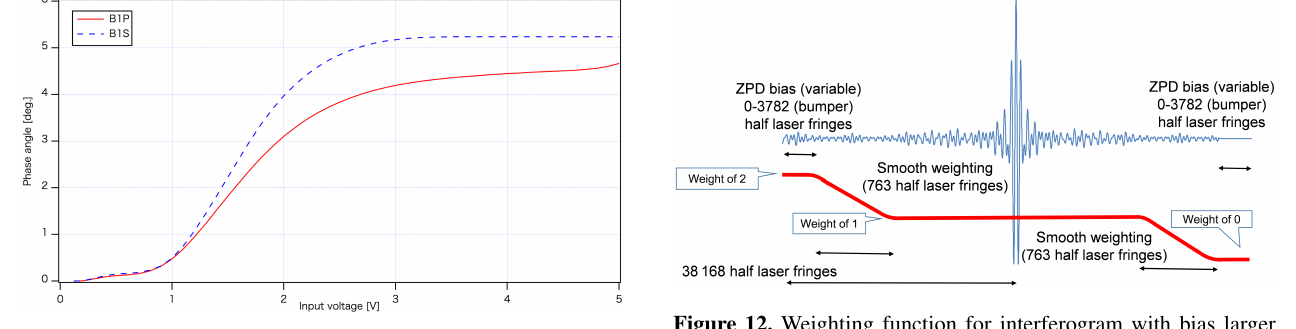
Figure 11. Intensity-dependent phase of the band 1 P (B1 P ) (solid line) and S (B1 S ) (dotted line) high gain analogue circuit. Higher gain B1 S has larger dependency.